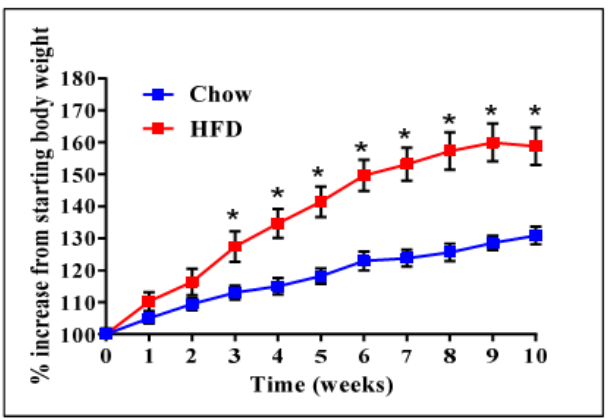
Figure 1. High fat diet (HFD) induced obesity in mice before small interfering RNA (siRNA) administration. n = 9 mice/group, * p < 0.05.